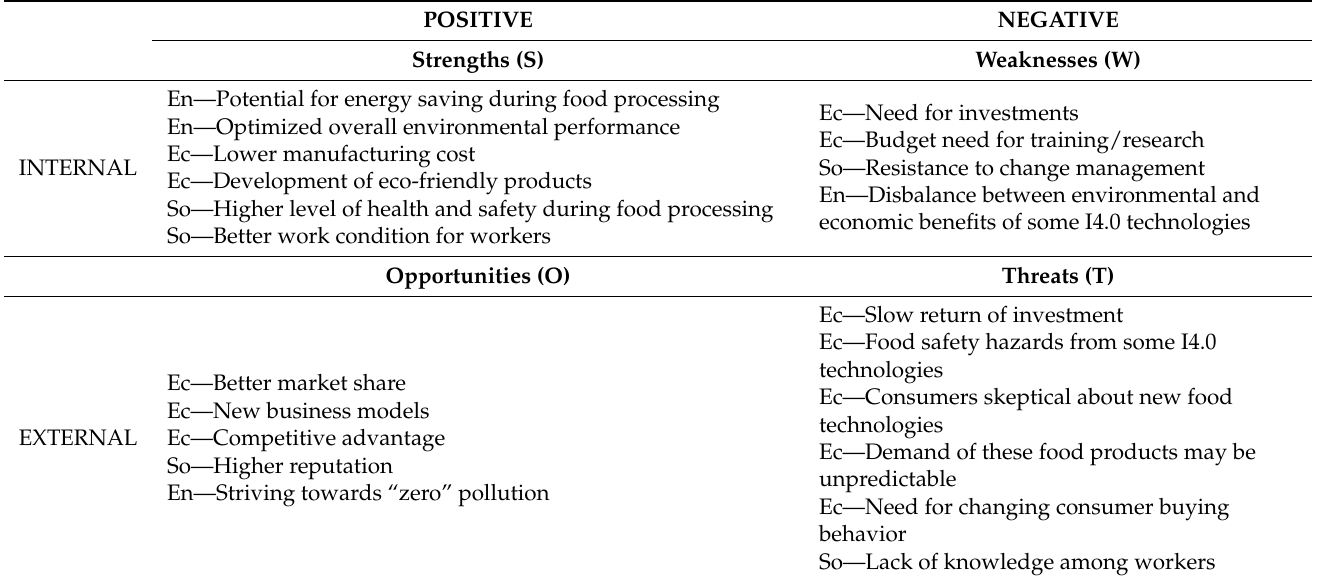
Table 4. The sustainability SWOT analysis for Food Industry